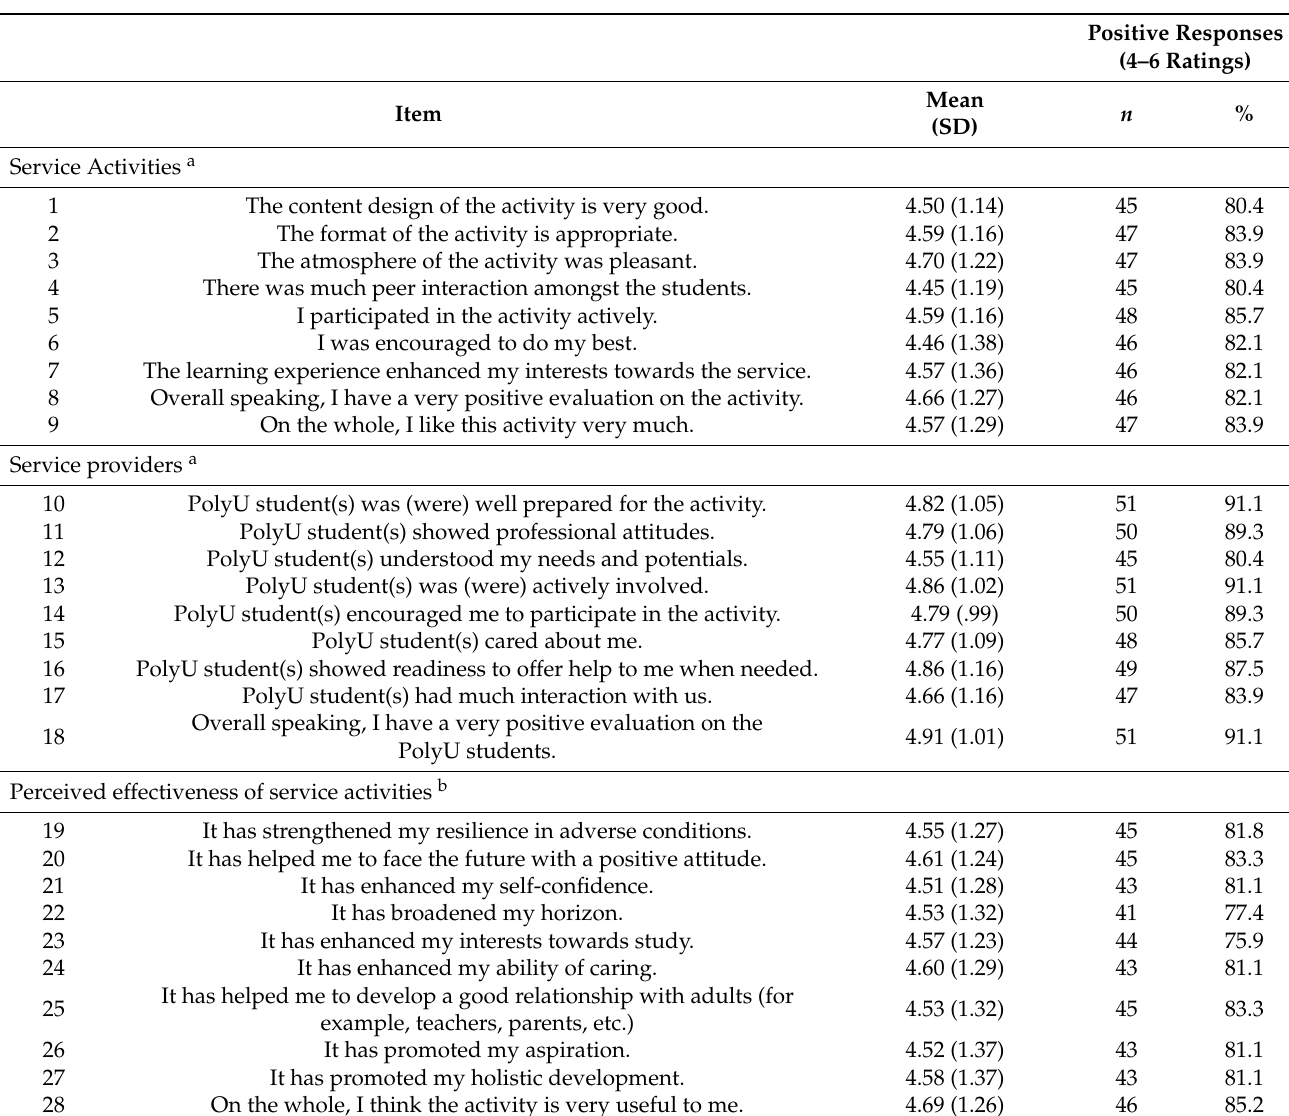
Table 4. Descriptive statistics and positive responses from the Subjective Outcome Evaluation by secondary school students (service recipients) ( n =